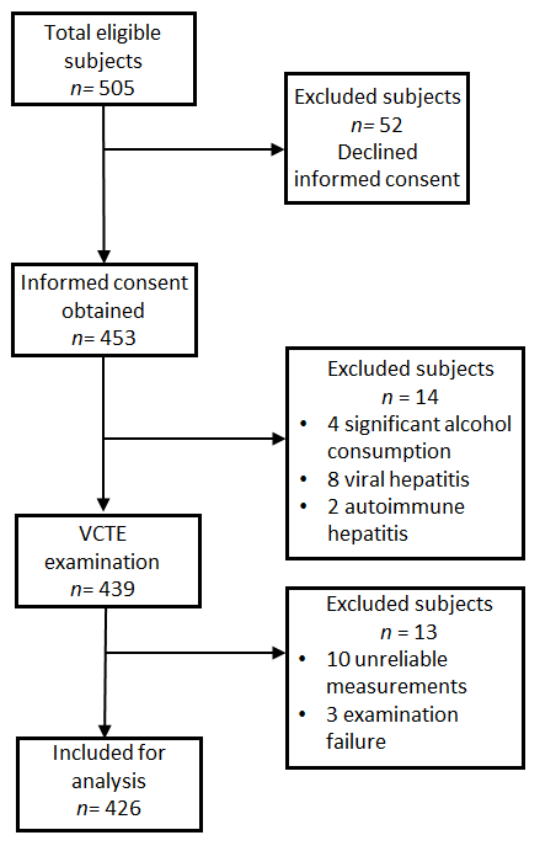
Figure 1. Participant flow-chart.